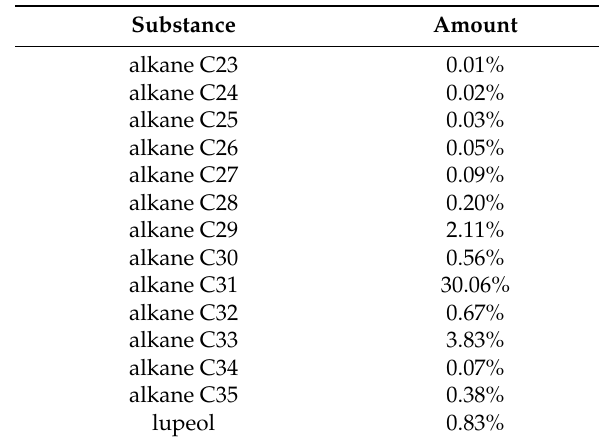
Table 4. Composition of candelilla wax used in this study. Analysis was performed with gas chromatography; original data are shown in Figure